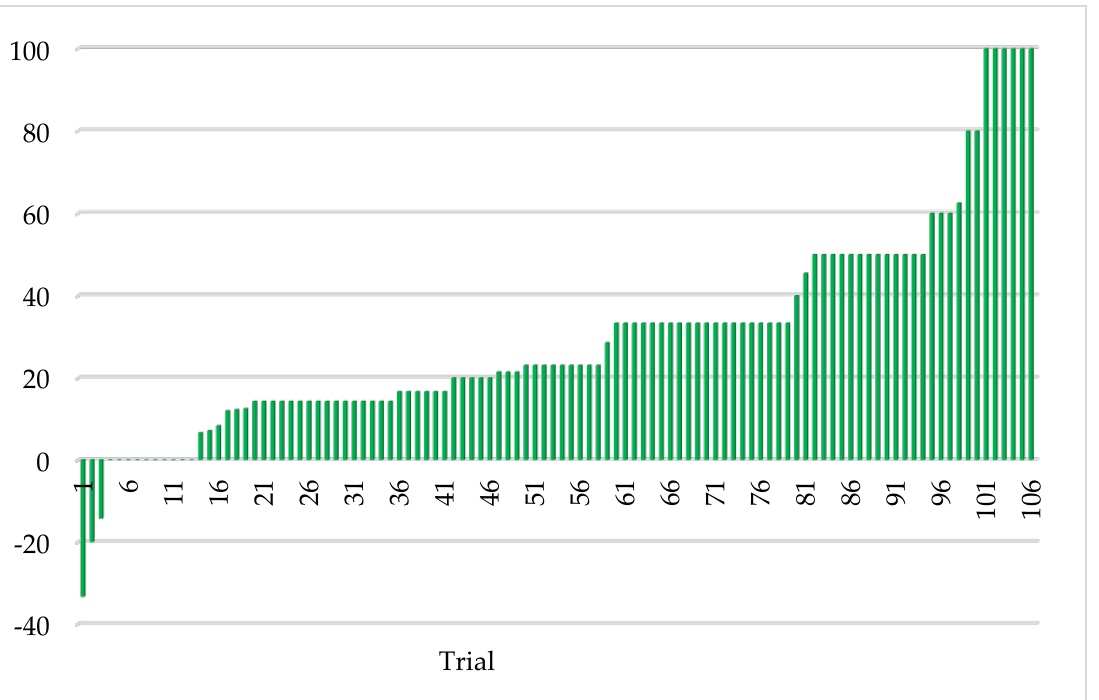
Figure 12. Mung bean response to BioEnsure. 183 trials (0.1 – 5.0 acres/plot) were performed with carry-over and market seed. Each bar represents a separate comparative trial of treated (ThMS3a) vs untreated plant yields. Win rate was 93% with a minimum of 10% yield increase. Each test had a single replication of treated and untreated so it was not possible to include standard deviations or statistical analysis. Cooperators: farmers. 4. Discussion Studies with weedy rice lines add to the body of knowledge that fungal endophytes play a significant role in the ecology, biology, and adaptation of plants [13,32 – 34]. It may also explain why breeding certain traits from native plants into domesticated plants has had limited success. Both C. brachyspora and F. asiaticum endophytes conferred stress tol- erance, increased biomass, and decreased water consumption in weedy rice and other